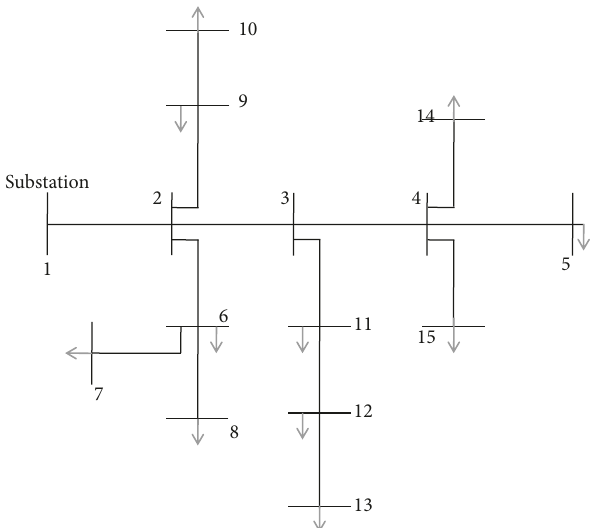
Figure 6: Single-phase diagram of the 15-bus distribution system.